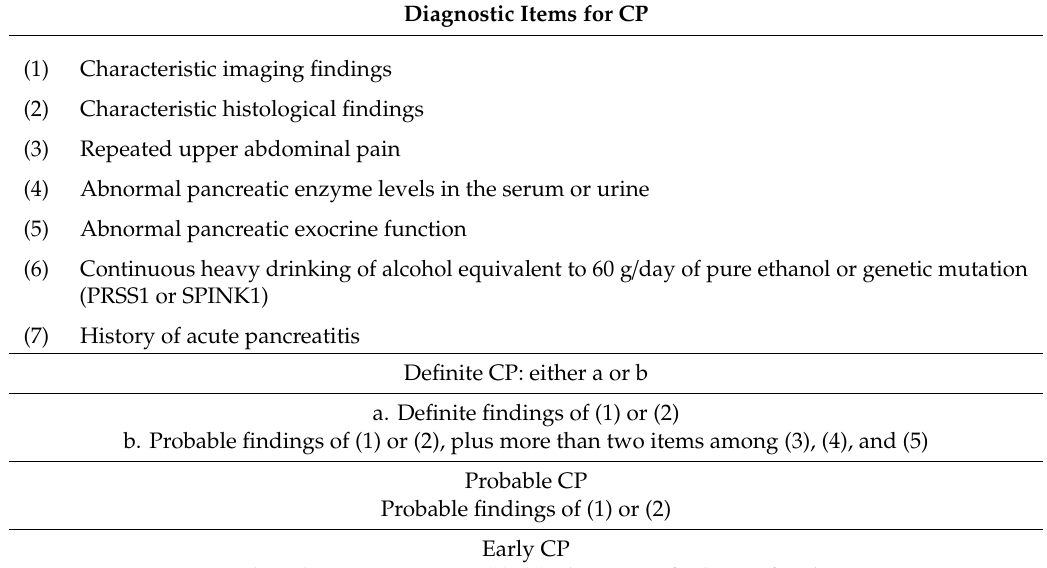
Table 2. Clinical diagnostic criteria for CP in 2019 by JPS.